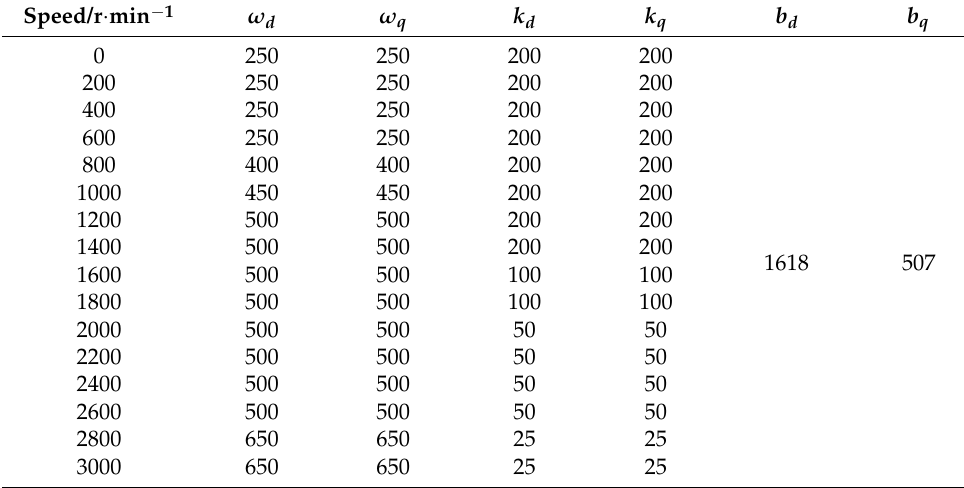
Table A1. ADRC parameters.